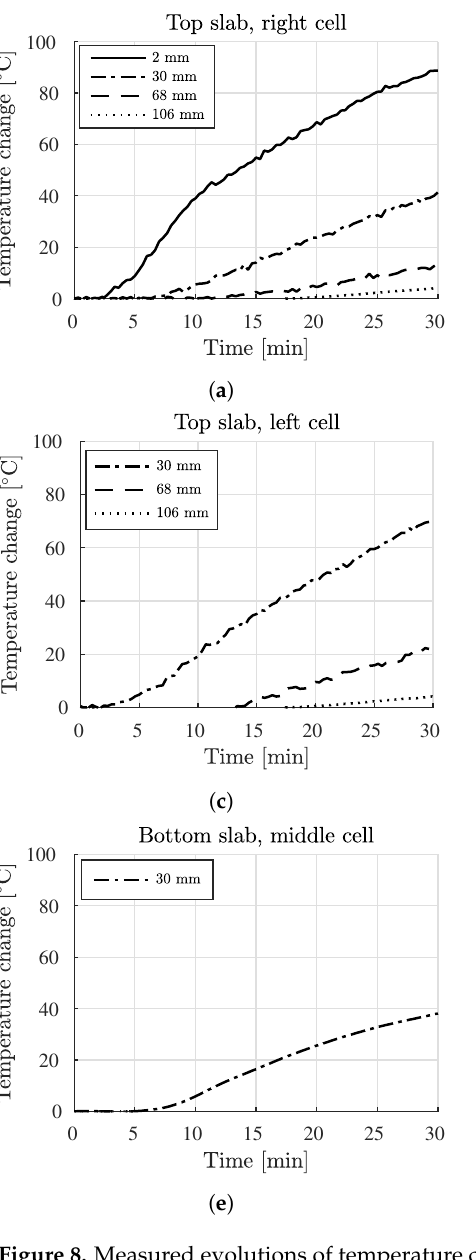
Figure 8. Measured evolutions of temperature changes: ( a ) top slab, at the midspan of the right cell, ( b ) top slab, at the midspan of the middle cell, ( c ) top slab, at the midspan of the left cell, ( d ) center of the right wall, ( e ) bottom slab, at the midspan of the middle cell, and ( f ) core of the right